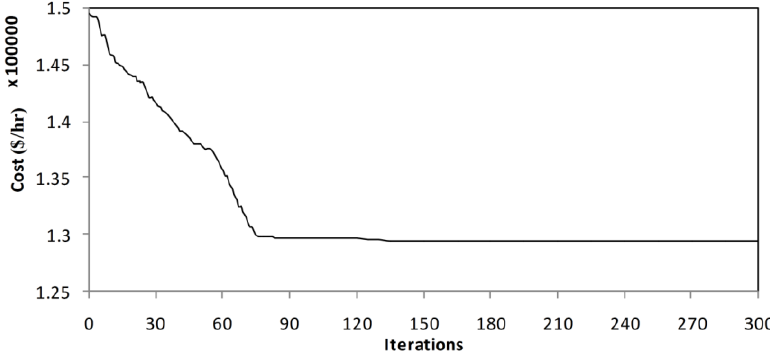
Figure 7. Convergence of Jaya method for case 4.